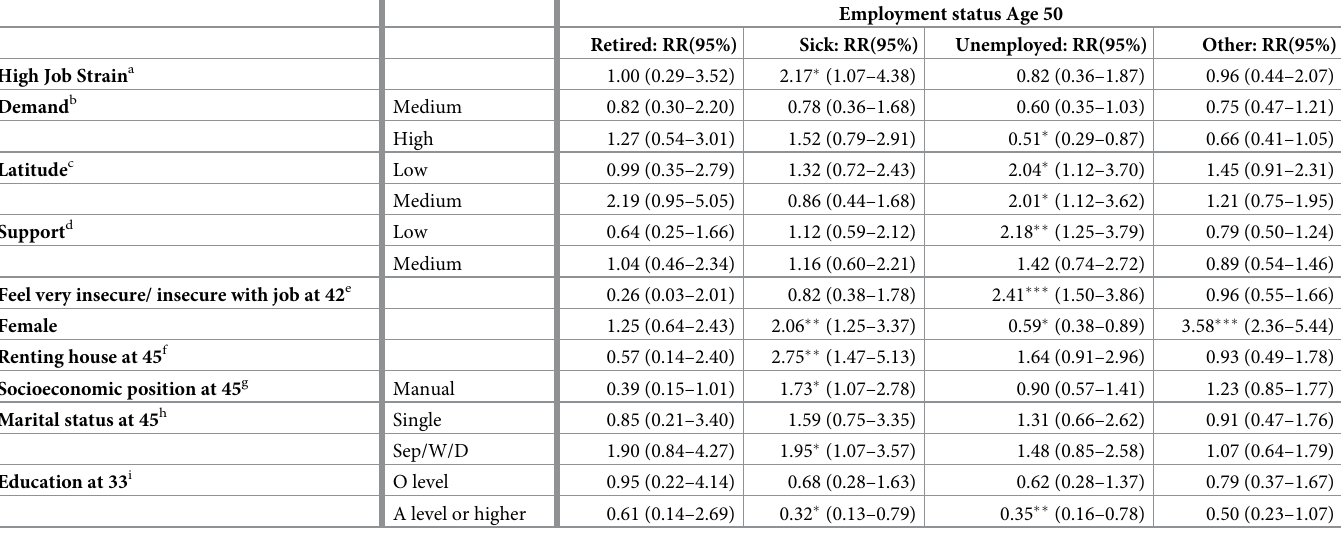
Table 2. Relative risks of work outcomes at age 50 for midlife sociodemographic factors and psychosocial work characteristics: Unadjusted models on imputed data. Paid work is the reference